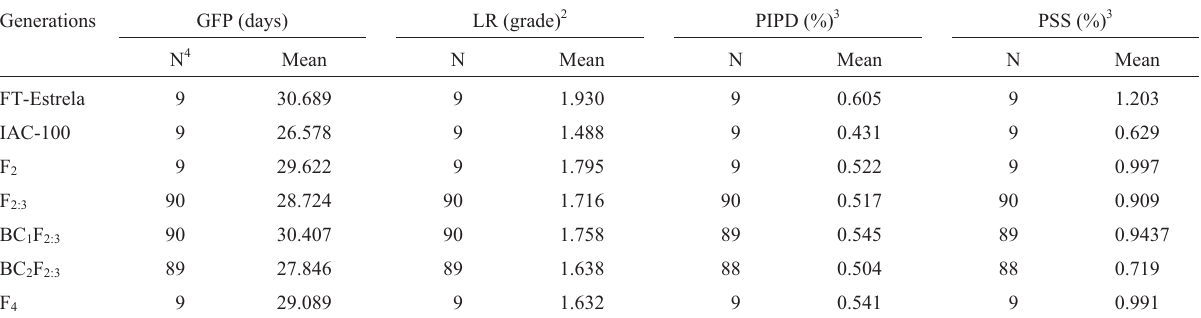
Table 2 - Joint-scale test information (Mather and Jinks, 1984) involving the parent lines FT-Estrela (G1) and IAC-100 (G2) and their segregating gener-